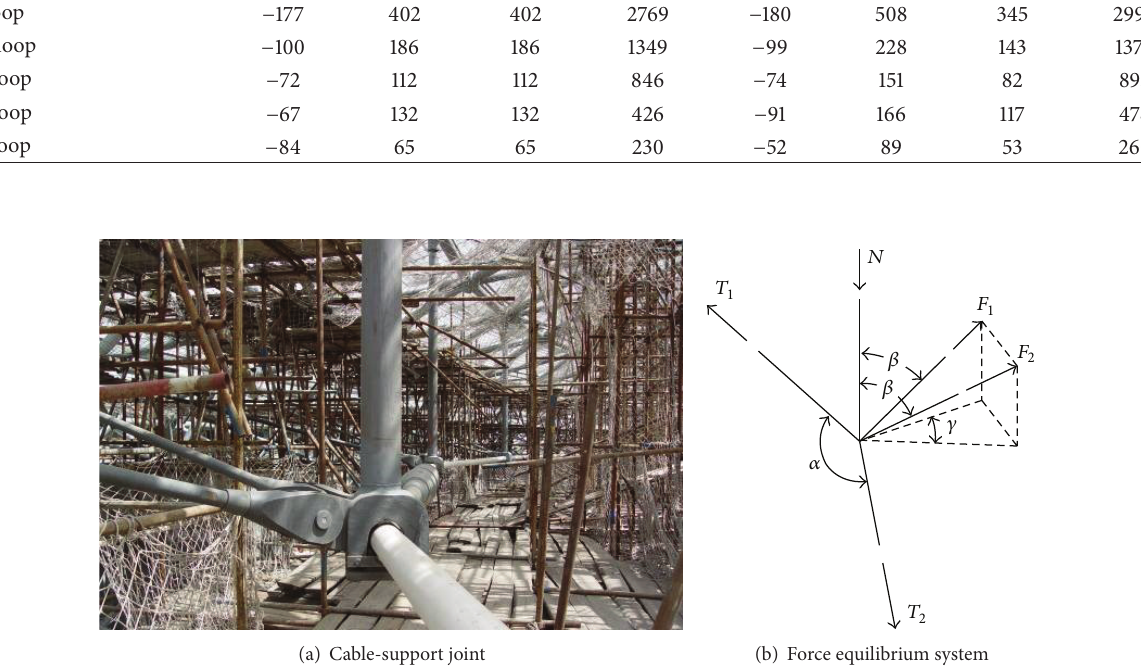
Table 5: Axial force of cable-support system at tensioned state considering temporary supports or friction of cable-support joint [kN]. Cable-support system number